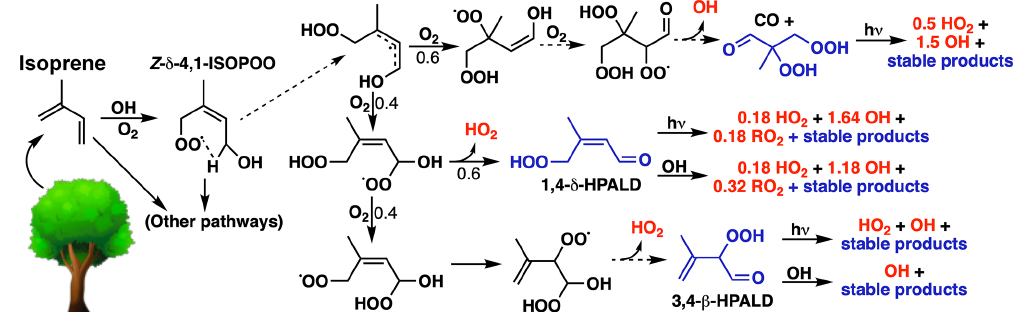
Figure 6. HO x production from H-shift chemistry in the reduced Caltech isoprene mechanism (RCIM). The figure shows HO x -generating pathways following the 1,6-H shift of Z - δ -1,4-ISOPOO. H-shift reactions are shown as dashed arrows, non-radical (closed-shell) products are shown in blue, and HO x production is shown in red. In RCIM, C 4 -dihydroperoxy-aldehydes (top right) are assumed to photolyze rapidly, resulting in a first-generation HO x recycling yield of 2.2 (1.5 OH + 0.7 HO 2 ) produced per ISOPOO H shift. Table 2. Percent changes in tropospheric concentrations due to isoprene. a Species Global 0–1km, global 5–10km, global SE USA b Amazon b E China b OH − 11 − 15 − 11 − 49 − 69 − 14 HO 2 6.5 NO x − 4 . 2 CO 30 HCHO 22 PANs Organonitrates d